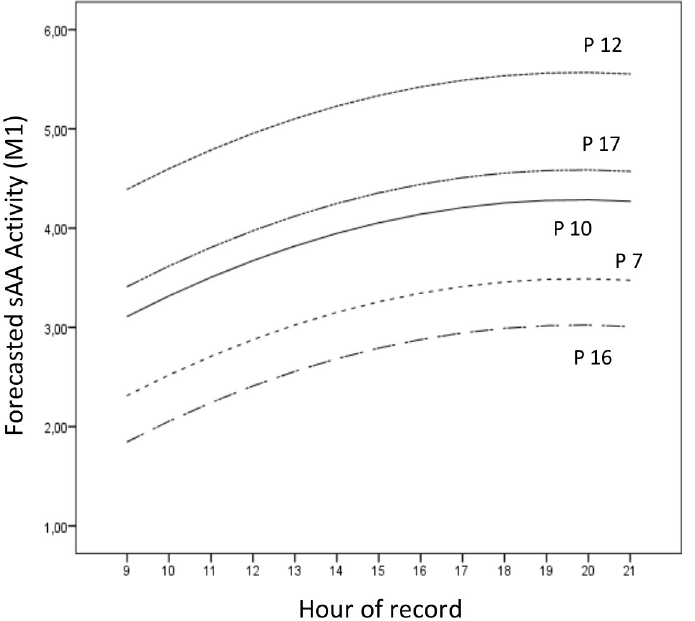
Fig 2. Forecasted values of P7, P10, P12, P16 and P17 (the same participants as in Fig 1), in accordance with Eq 9 ( M1 ), from 09:00 to 21:00 hr.